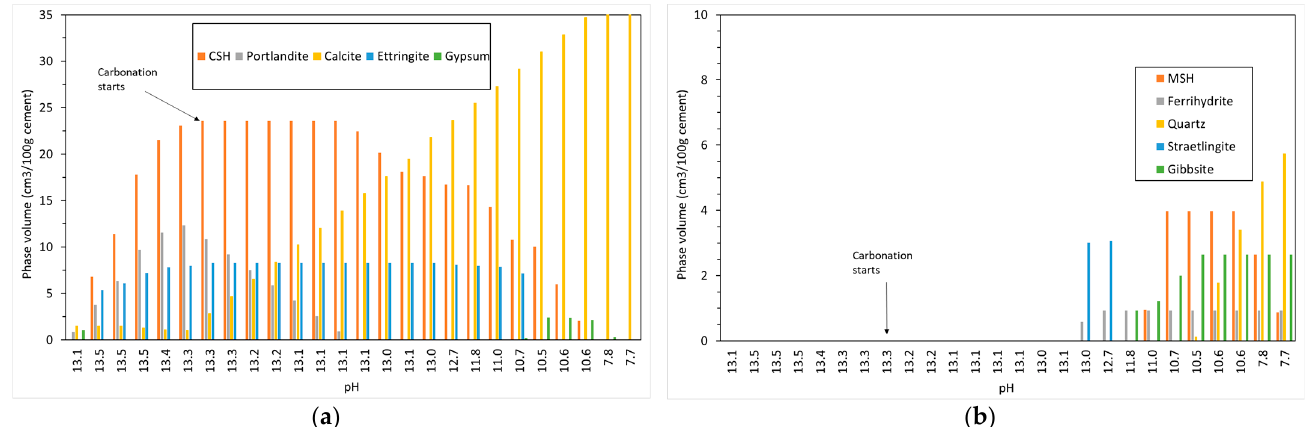
Figure 4. Change in solid phase volume with pH with increasing CO 2 ingress for ( a ) CSH, portlandite, calcite, ettringite and gypsum and ( b ) MSH, ferrihydrite, quartz, straetlingite and gibbsite.